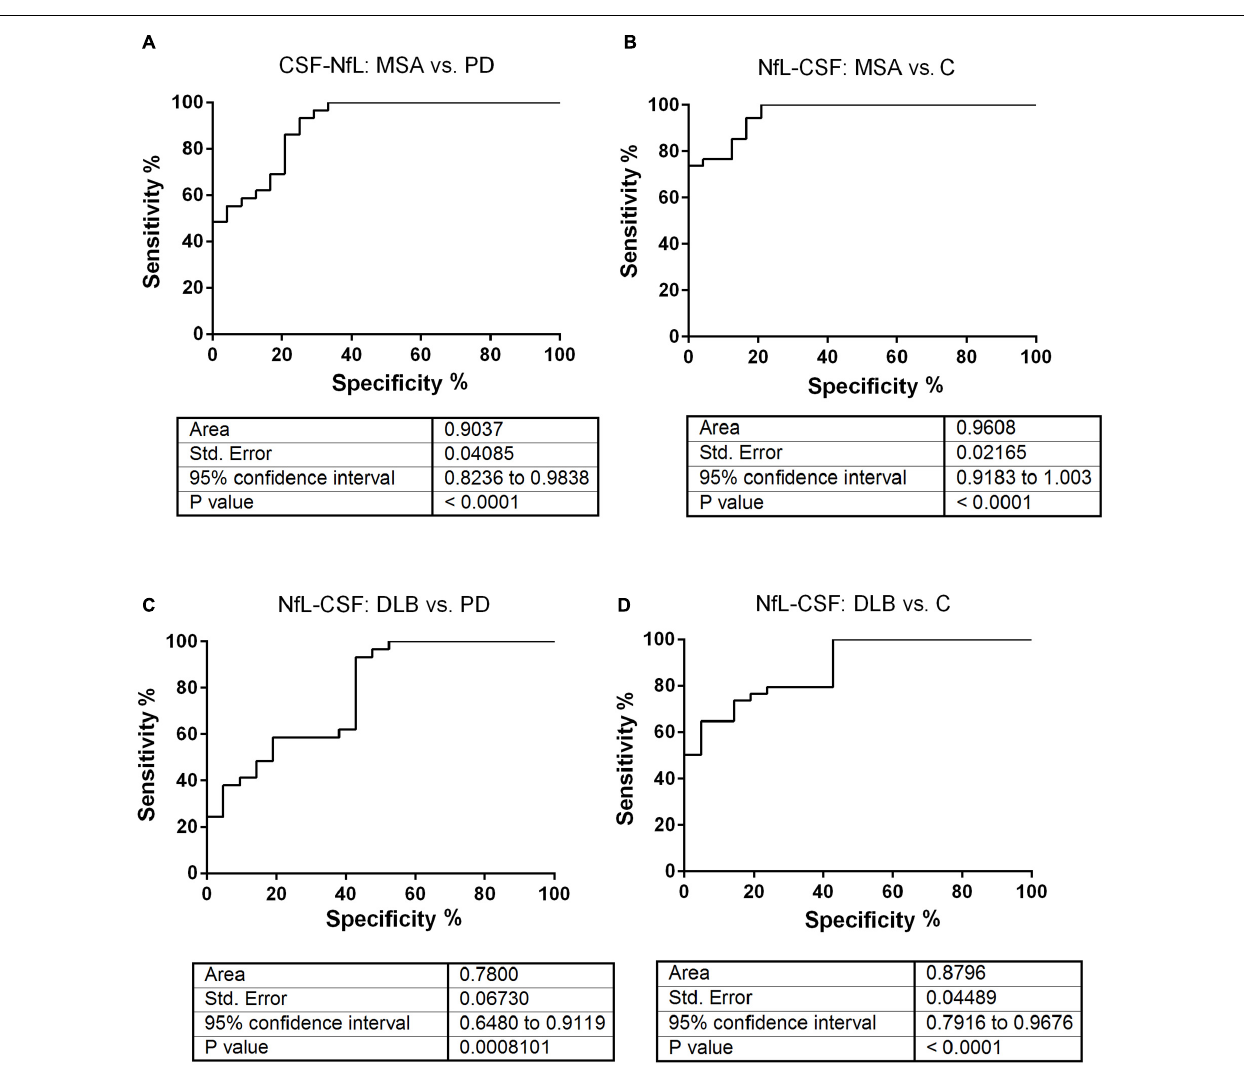
FIGURE 3 | Receiver operating characteristic curve analysis of CSF-NfL levels from patients with MSA and DLB. ROC analyses were performed with the CSF-NfL concentrations obtained for the different diagnostic groups. (A,B) The diagnostic accuracy of CSF-NfL was assessed with ROC-derived AUC values (with 95% CI) for the discrimination of patients with MSA from PD and controls. The AUC values of 0.90 ± 0.04 SD, 95% CI of 0.82–0.98 and 0.96 ± 0.02 SD, 95% CI of 0.91–1.00 indicated a very good diagnostic accuracy. (C,D) The diagnostic accuracy of CSF-NfL was assessed for the discrimination of patients with DLB from PD and controls (indicated as C). The AUC values of 0.78 ± 0.07 SD, 95% CI of 0.65–0.91 and 0.88 ± 0.04 SD, 95% CI of 0.79–0.97 indicated a good diagnostic